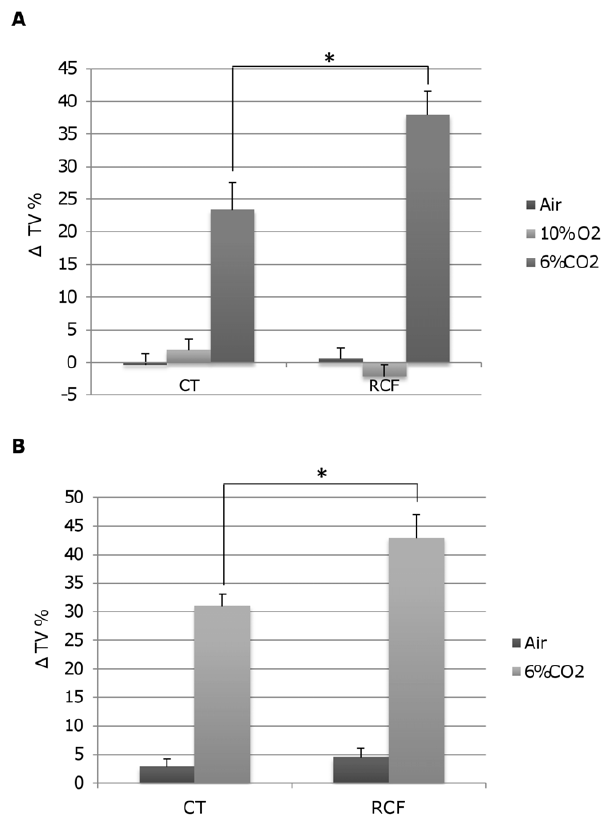
Figure 4. Respiratory responses to air, 10%O 2 , or 6%CO 2 in CT and RCF subjects at different ages. Percentage of tidal volume changes from baseline ( D TV%) for: a ) 16–20 day-old pups in response to normal air, 10% O 2 , or 6% CO 2 . The ANOVA-R carried out on two